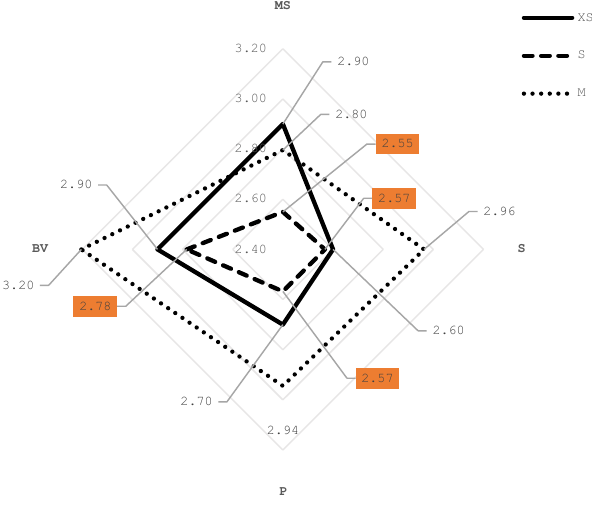
Fig. 2 – Spider chart: The influence of design on selected corporate results with regard to the business size. Source: own